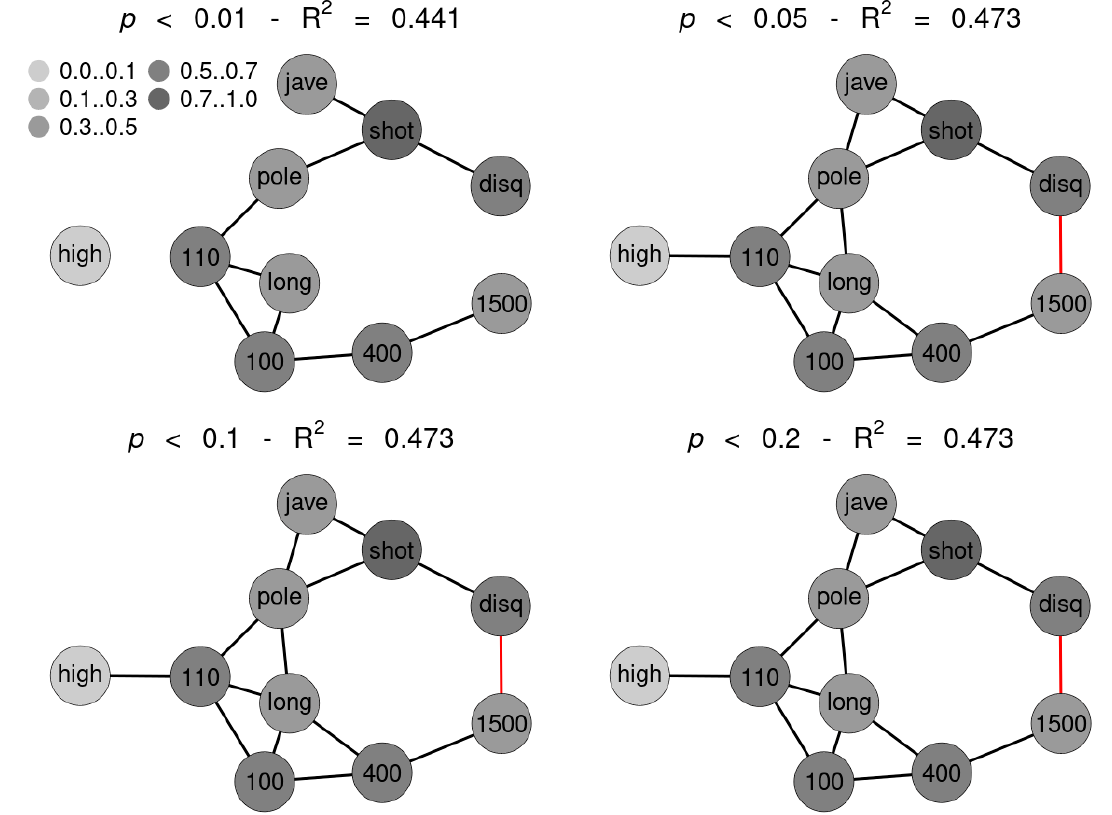
Figure 5. Four St. Nicholas House Analysis (SNHA) graphs (sample 1) for different alpha values ( p -value threshold at 0.01 ( top left ), at 0.05 ( top right ), at 0.1 ( bottom left ) and at 0.2 ( bottom right )). Gray shades depict the amount variance that for each variable is explained by SNHA algorithm. R 2 indicate the total variance of each of the sport disciplines at the given alpha values p = 0.01 to p = 0.20. similar R 2 indicates similar validity of the model. The SNHA algorithm is robust towards the threshold chosen. Black edges indicate positive, red edges indicate negative correlations.